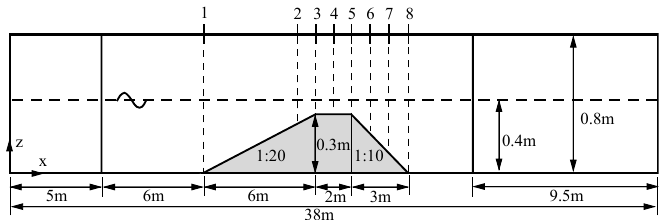
Figure 3. Numerical setup for the simulation of the wave propagation over a submerged bar.